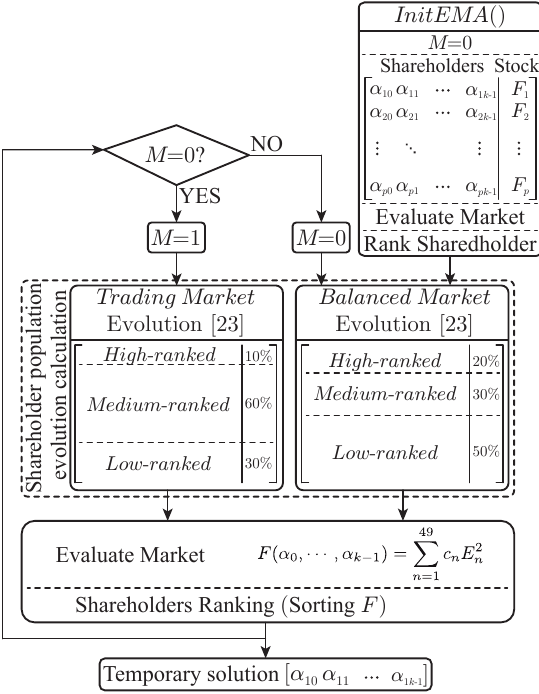
Figure 2. Exchange Market Algorithm (EMA) flowchart to find a solution set of switching angles that minimizes cost function F